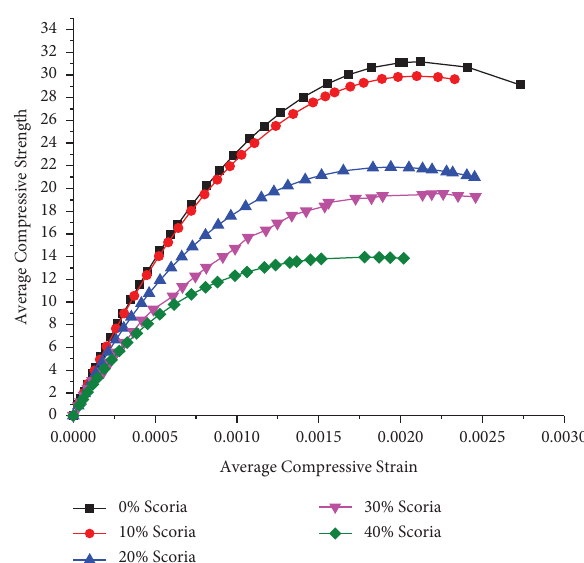
Figure 7: Stress-strain curve for 7 days compressive strength